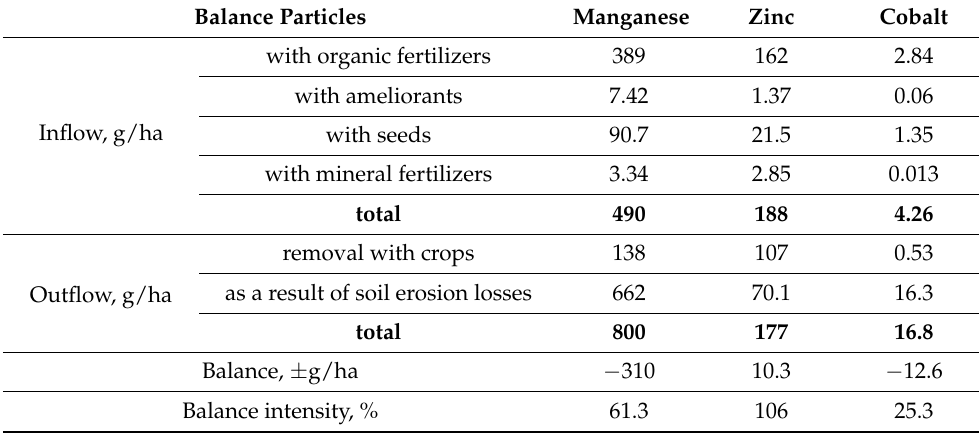
Balance intensity,